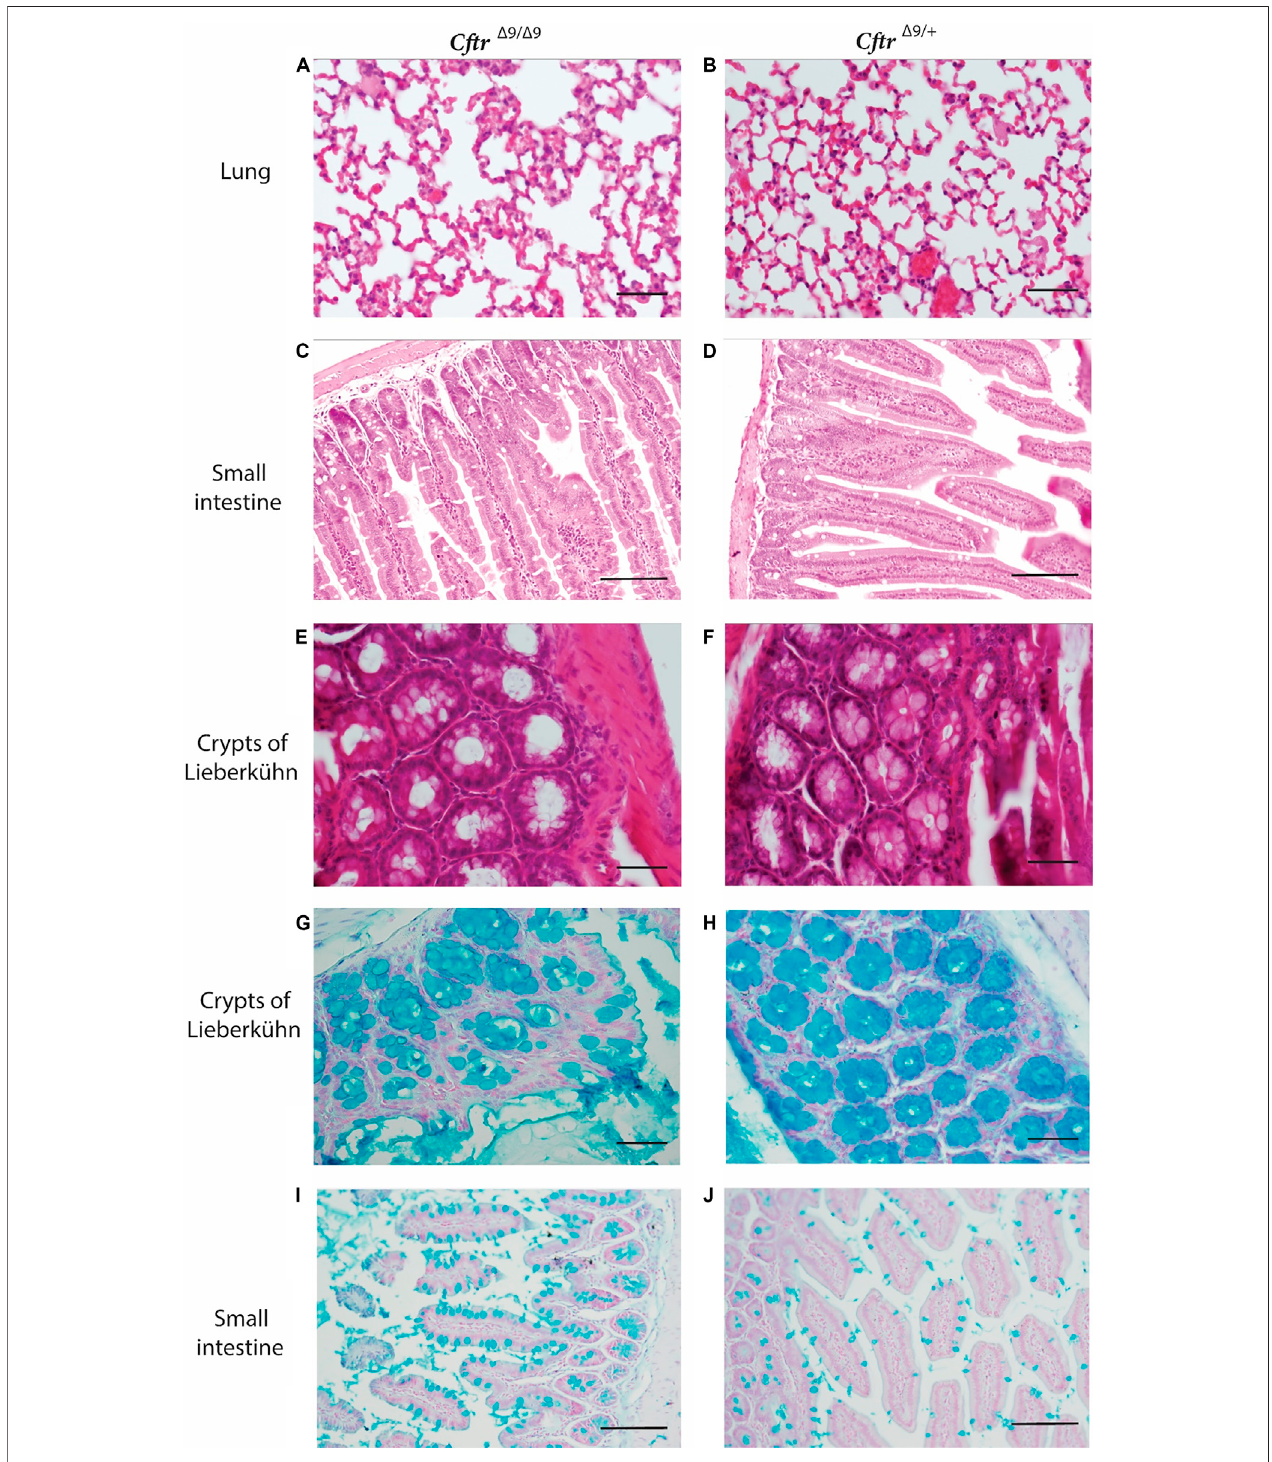
FIGURE 2 | Hematoxylin and Eosin and Alcian Blue staining of representative lung and intestinal sections from Cftr Δ 9/ Δ 9 and Cftr Δ 9/+ (control) mice. (A – F) Hematoxylin and Eosin stained (A) . Lung section for Cftr Δ 9/ Δ 9 mouse. (B) . Lung section for Cftr Δ 9/+ mouse. (C) . Small intestinal section from Cftr Δ 9/ Δ 9 mouse. (D) . Intestinalsectionfrom Cftr Δ 9/+ mouse. (E) .CryptsofLieberkühnsectionfrom Cftr Δ 9/ Δ 9 mouse. (F) .Lieberkühnsectionfrom Cftr Δ 9/+ m ouse. (G – J) Alcainbluestained (G) . a Cftr Δ 9/ Δ 9 mouse and (H) . Cftr Δ 9/+ mouse showing Crypts of Lieberkühn. Sections of small intestine from (I) . Cftr Δ 9/ Δ 9 mouse and (J) . Cftr Δ 9/+ mouse, showing goblet cells. n = 4. Images (A,B) , (E – H) were taken at ×40 (scale bar 20 micrometres) and (C,D) , (I,J) were taken at ×20 (scale bar 50 micrometres).